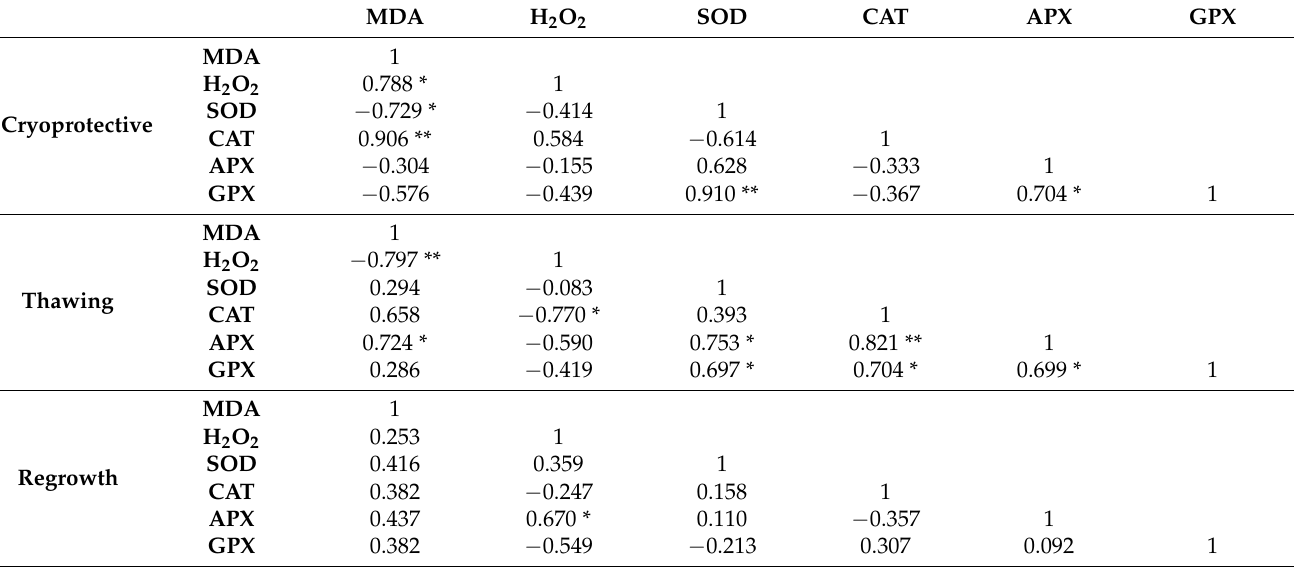
Table 1. Correlation values obtained for MDA, H 2 O 2 , SOD, CAT, APX, and GPX of G. chacoensis embryogenic cultures in each evaluation time: after cryoprotective solution, after thawing, and after regrowth. MDA H 2 O 2 SOD CAT APX